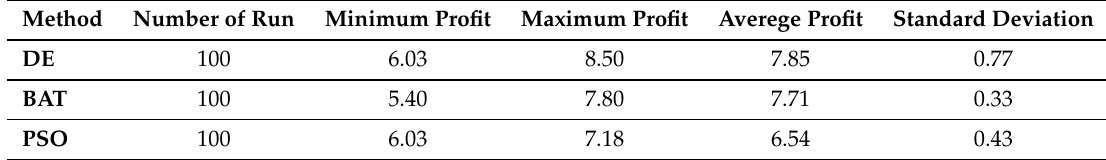
Table 1. Comparison of deviation, average and minimum cost between applied optimization